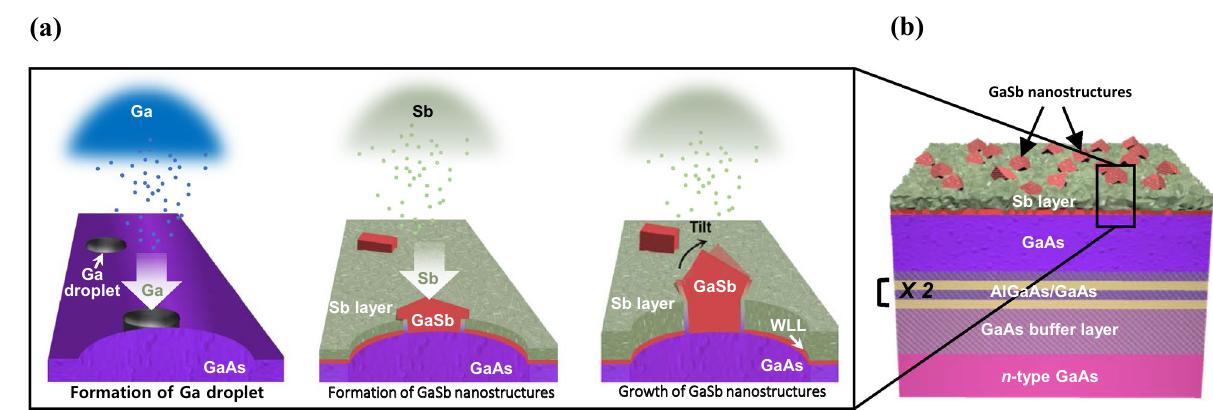
Figure 1. Schematic of ( a ) self-growth mechanism of the GaSb QD using Ga droplet without GaAs capping layer, and ( b ) GaSb QD structure on GaAs wafer.